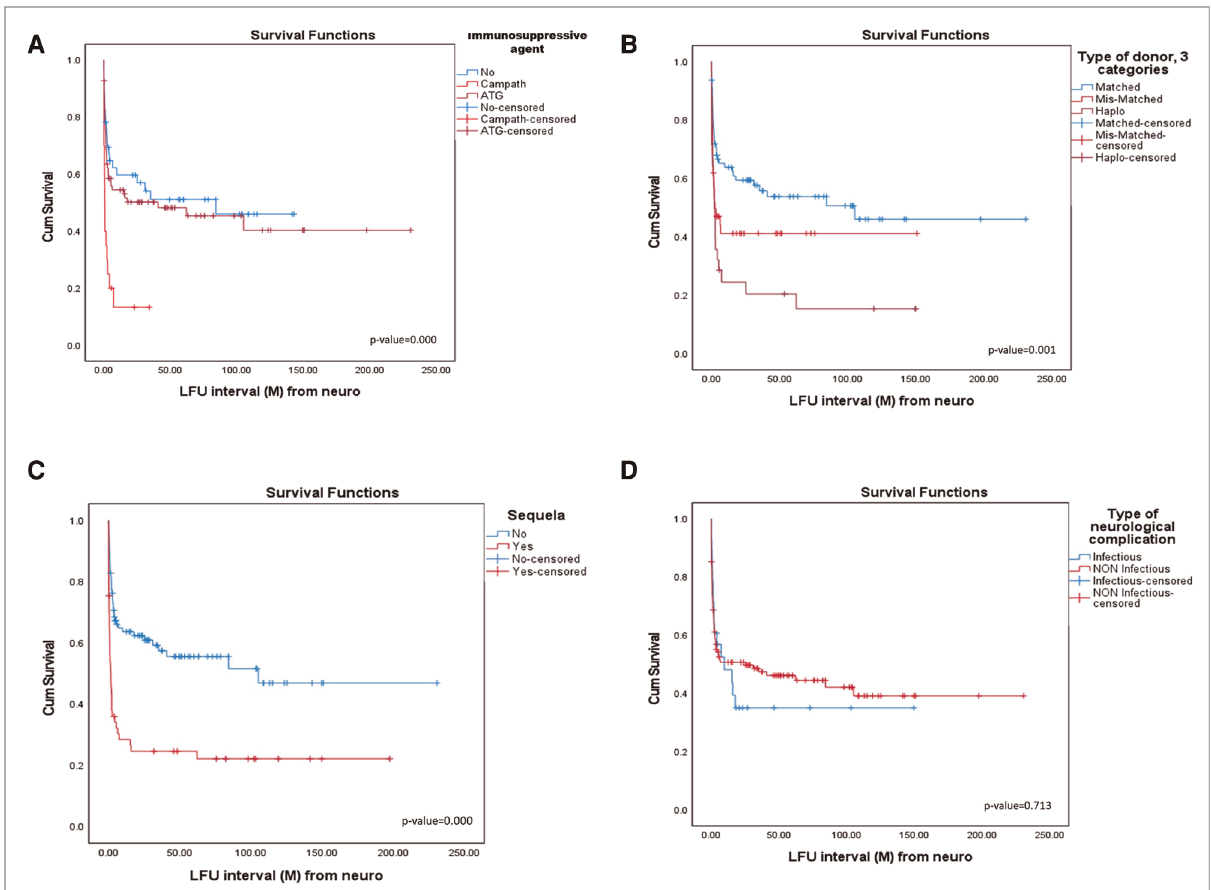
FIGURE 1 ( A ) Survival according to immunosuppressive agent. ( B ) Survival according to type of donor. ( C ) Survival according to neurological sequelae. ( D ) Survival according to type of neurological